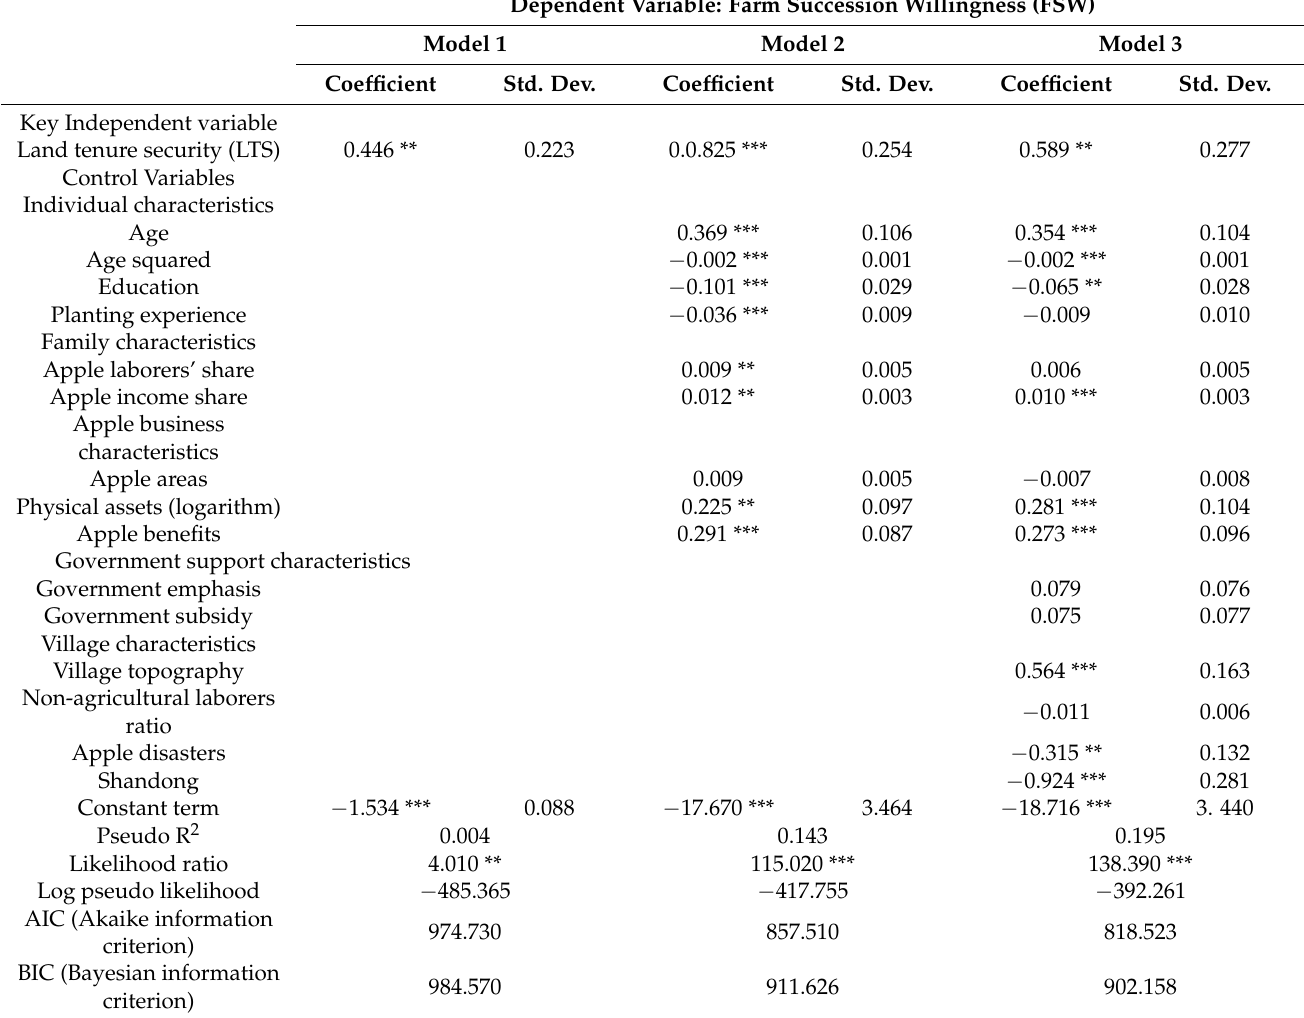
Table 2. Impact of LTS on